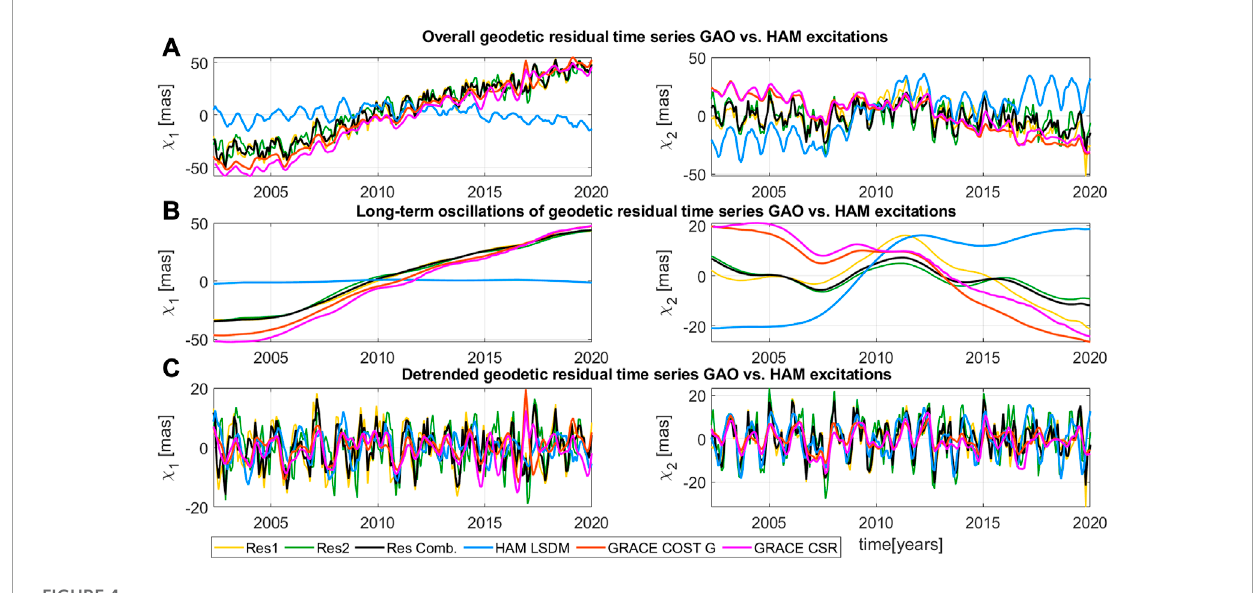
FIGURE 4 Time series comparison of equatorial components of the χ 1 and χ 2 of geodetic residuals (Res1, Res2, and Res Comb.) and gravimetric-based excitation determined from GRACE/GRACE-FO solution of CSR and COST-G solutions and HAM LSDM excitaions for (A) overall, (B) long-term trend, and (C) detrended oscillations. The non-linear long-term oscillations were deremined using MSSA method.